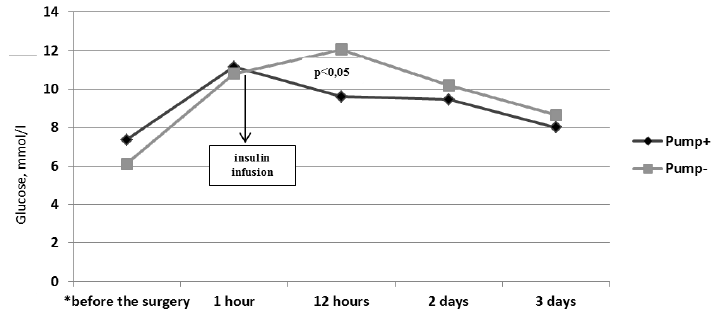
Figure 2. Glucose levels dynamics in patients with T2DM in the perioperative period according to CGMS, mmol/L. * Glucose levels in patients on insulin pump (Pump+) ( Ме (Q25; Q75)) before the surgery—7.35 (5.63; 9.15); 1 h after the surgery—11.5 (9.78; 15.07); 12 h after the